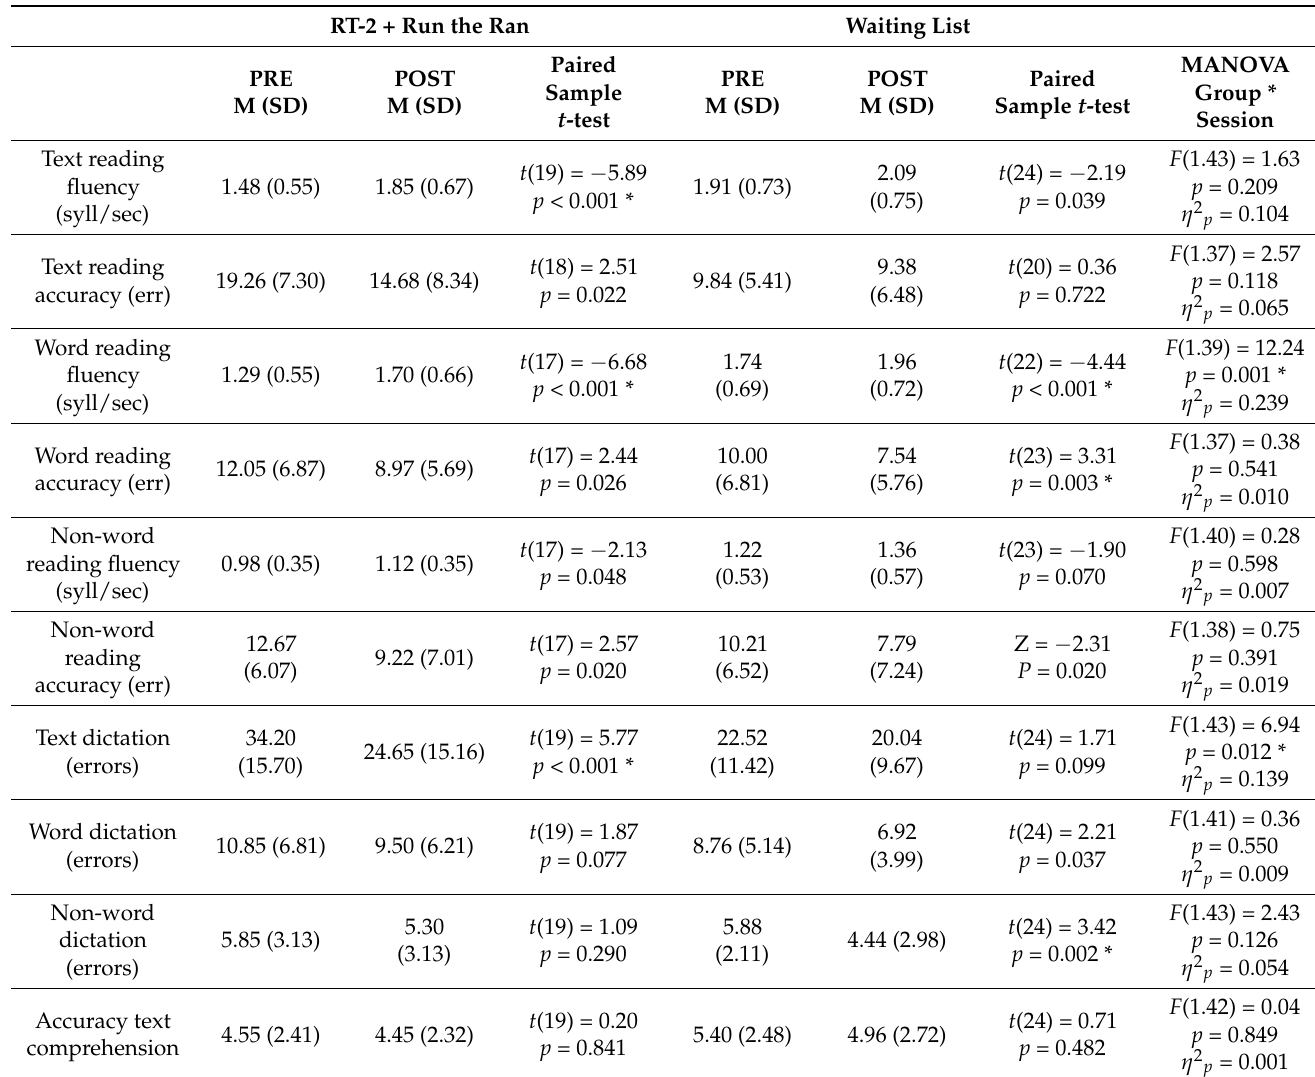
Table 2. Performance at pre- and post-test of children with SLD attending RT-2 + Run the Ran apps and waiting list group and results of the MANOVA for the Group * Session interaction. RT-2 + Run the Ran Waiting List